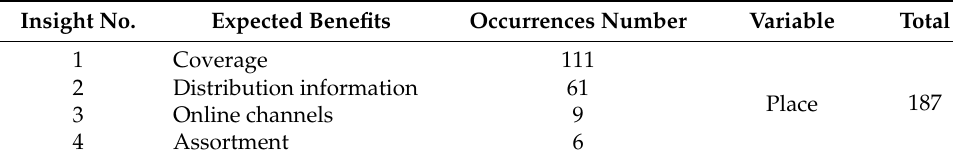
Table 4. Subgroups of comments classified into the distribution pillar. Insight